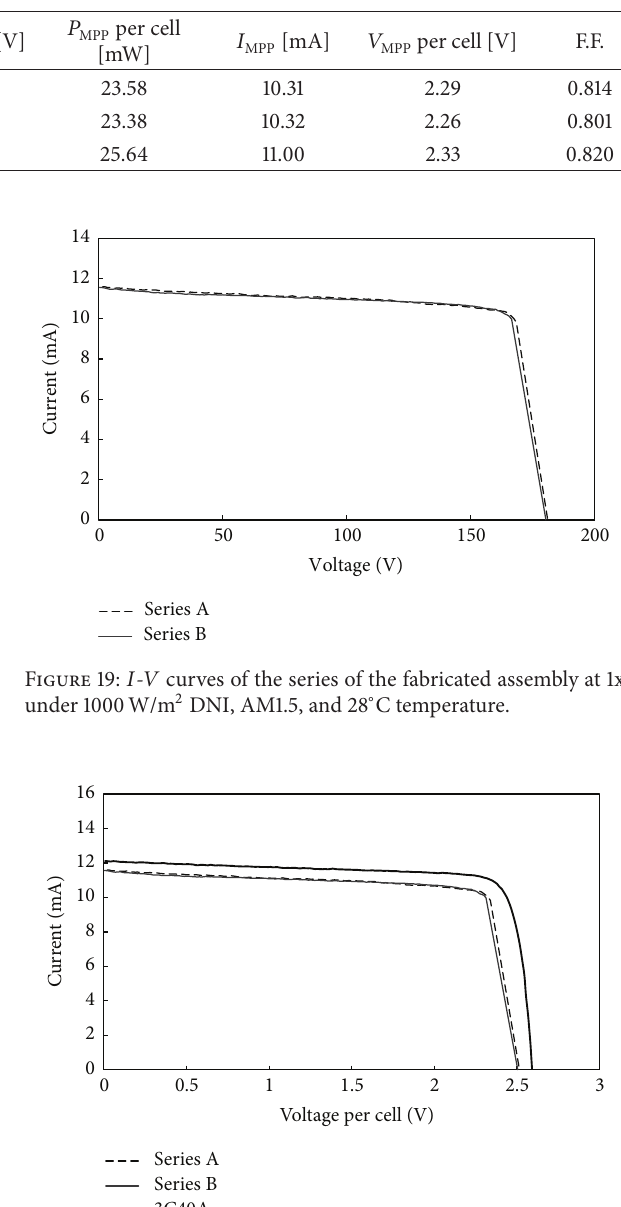
Table 8: Electrical outputs per cell of the two series of the produced cell assembly, compared with those of the commercial 3C40A assembly, under AM1.5, 1000W/m 2 , at 28 ∘ C.